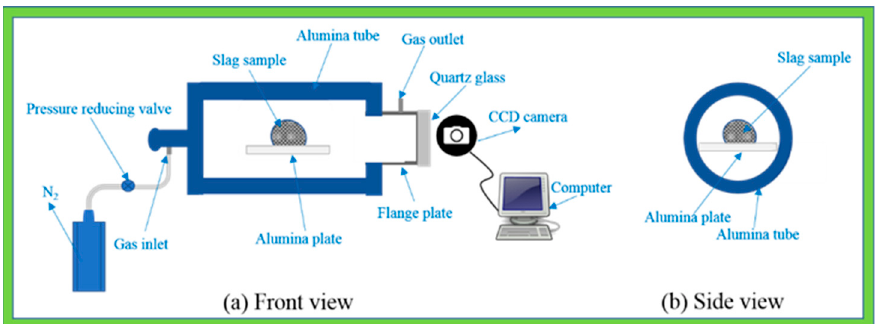
Figure 1. Schematic of experimental setup.